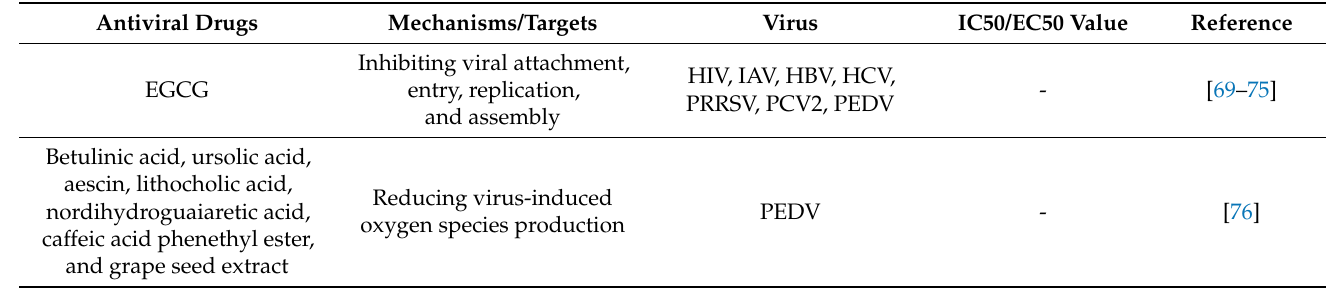
Table 4. Antiviral natural antioxidants and the antiviral